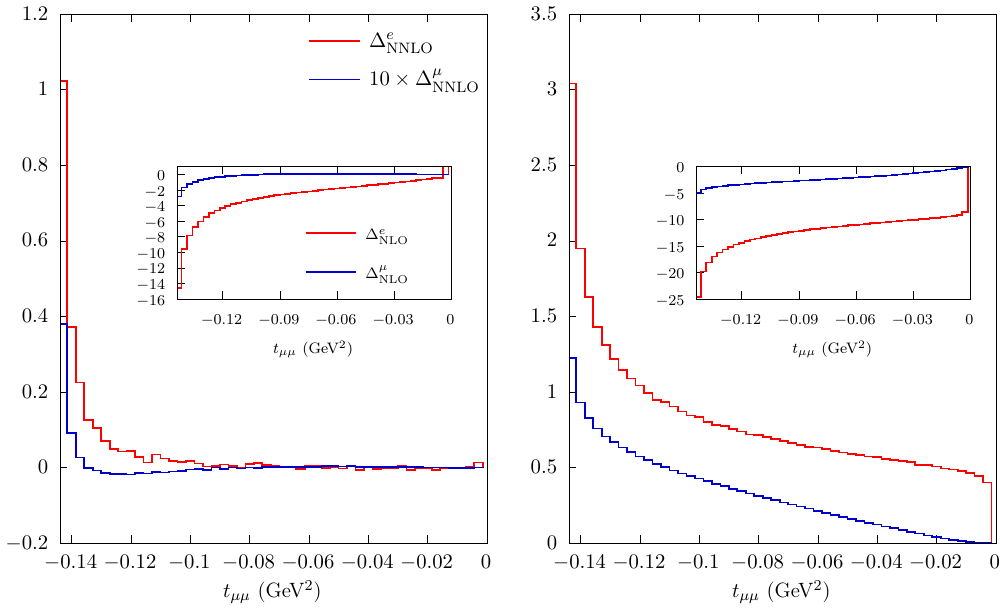
Figure 8 . The same as (cid:12)gure 3 for the squared momentum transfer measured along the muon line, t (cid:22)(cid:22) .